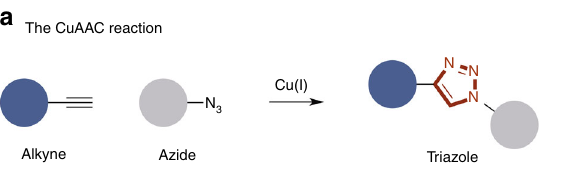
Chemoselective transformation using non-biological functional groups - bioorthogonal Regiospecific formation of 1,4-disubstituted 1,2,3-triazoles Broad application in chemical, biological, and material sciences